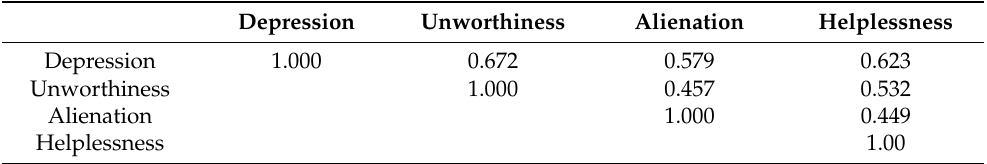
Table 3. Sample correlations between the dependent